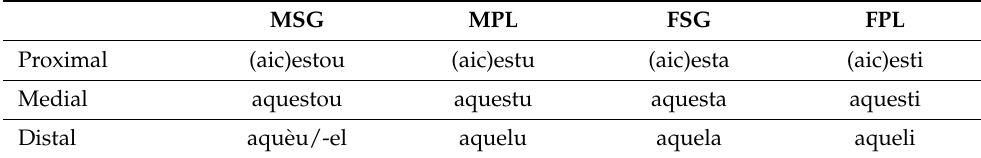
Table 3. Paradigm of